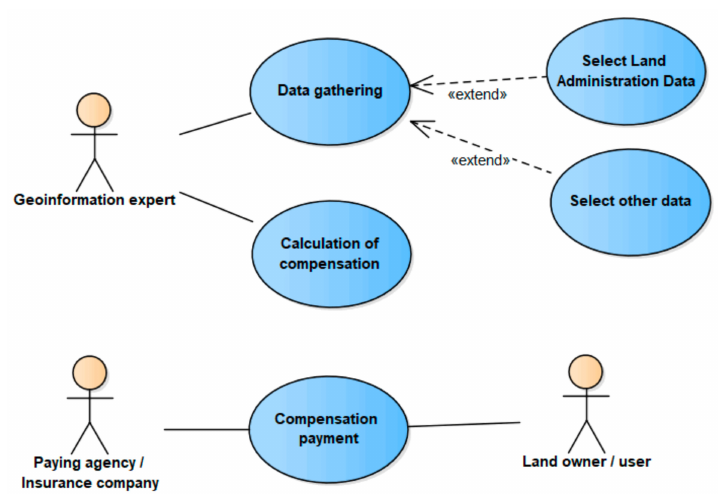
Figure 1. Paradigm of the system of